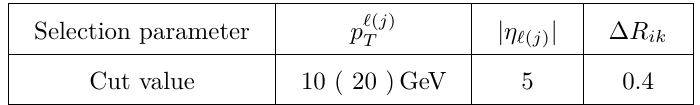
Table 2 . The selection criteria used throughout the analysis, where ‘ = e, µ and j = u, d, c, s and g . The distance between two objects i and k is defined as ∆ R ik = η i and φ i are the rapidity and azimuthal angle of the object i , respectively. τ -jets of 1%. The statistical significance is given by S = p 2 [( S + B ) ln(1 + S/B ) − S ] , where S and B respectively are the number of expected signal and background events at a particular integrated luminosity L